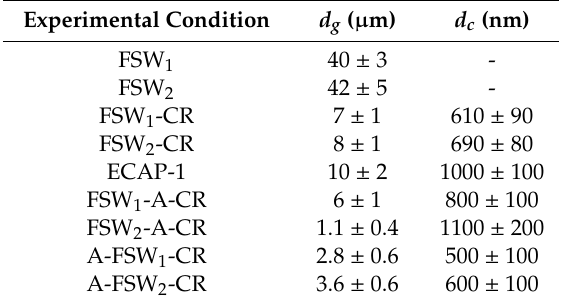
Table 2. Mean grain, d g , and cell (subgrain), d c , sizes.